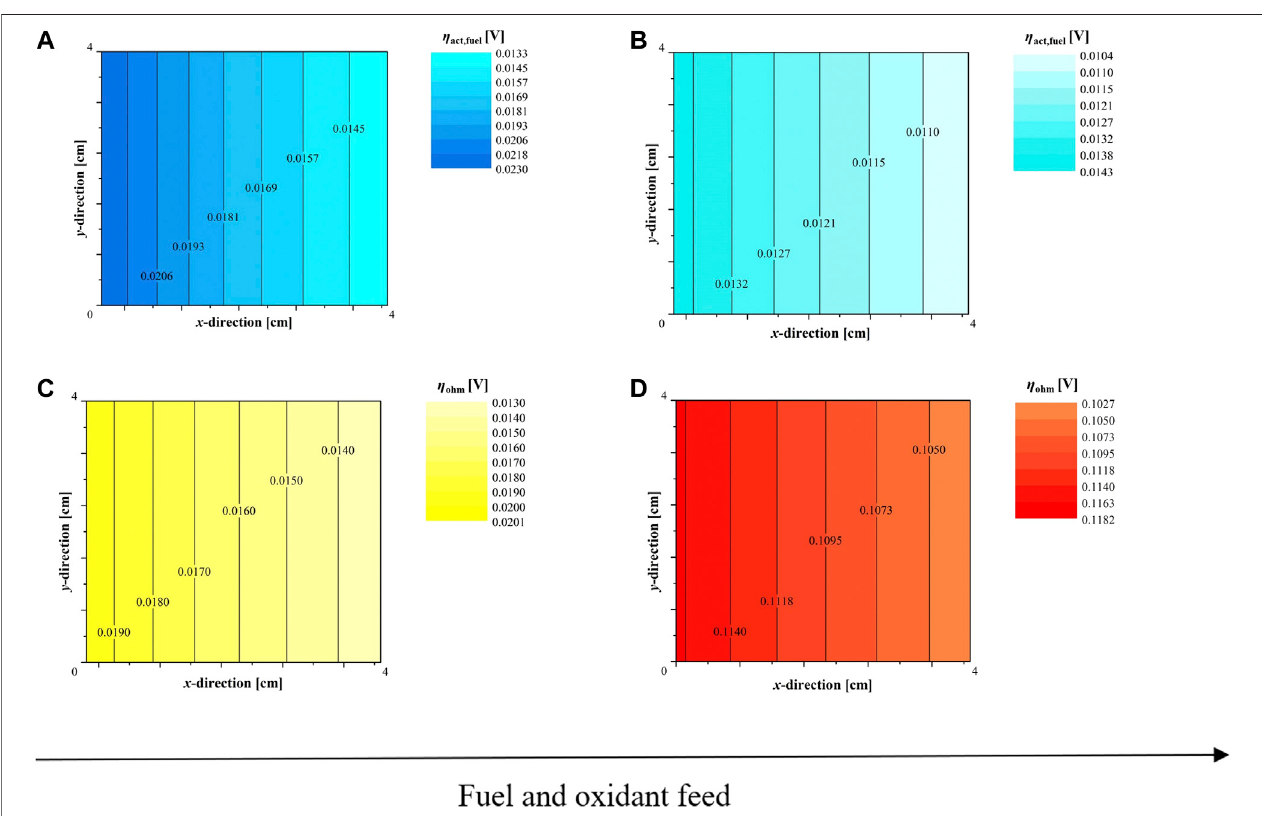
FIGURE 11 | Local cell performance feeding 80/20 H 2 /H 2 O mixture and dry air at 850 ° C: (A) ASC and (B) ESC activation overpotential at fuel electrode, (C) ASC and (D) ESC ohmic overpotential according to SIMFC